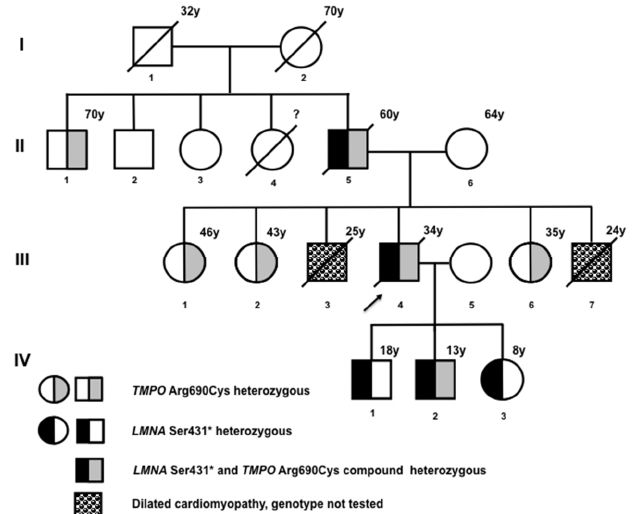
Figure 1. Family Pedigree. The arrow points to the proband on whom next-generation sequencing was performed. Squares and circles half-filled in black are heterozygous LMNA Ser431* mutation carriers, squares, and circles half-filled in gray are heterozygous TMPO Arg690Cys polymorphism carriers. Individuals II-5, III-3, III-4, and III-7 had clinical manifestations of dilated cardiomyopathy; the genotype was not tested in individuals III-3 and III-7.